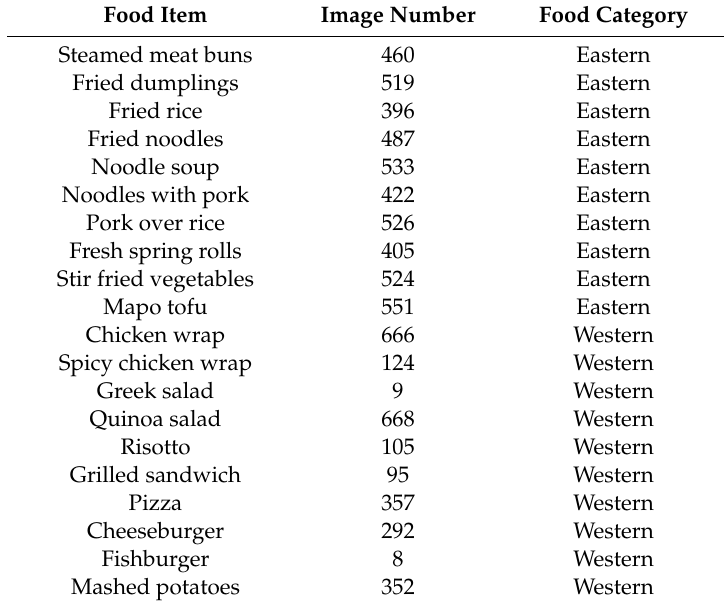
Table A1. Table of food items included in the eye-tracking paradigm. Extracted from the